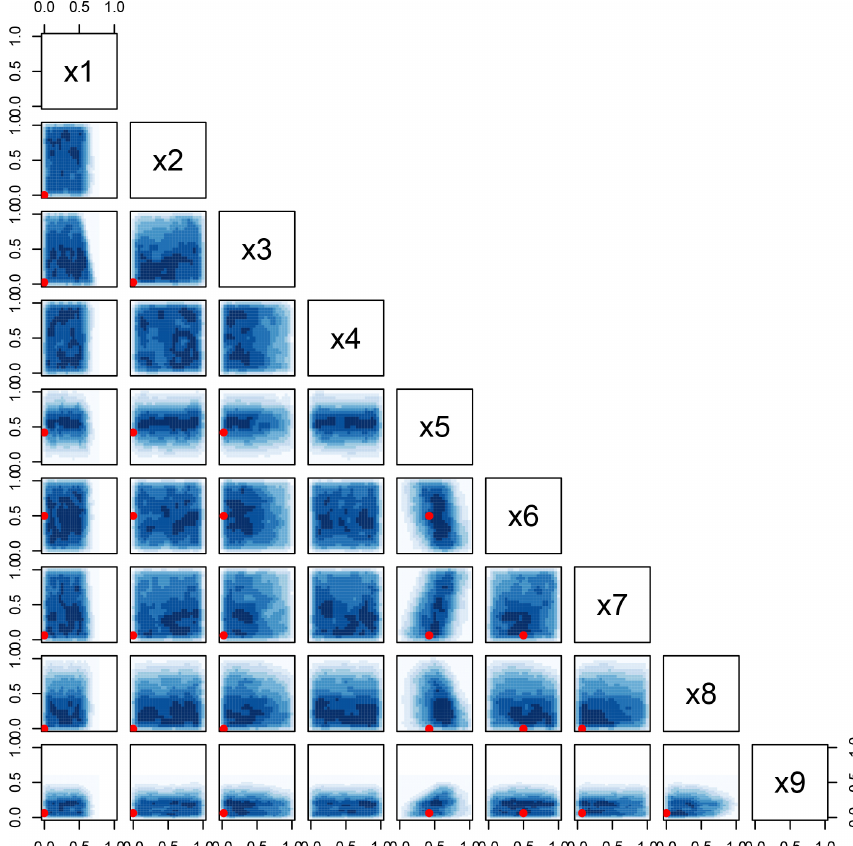
Figure 5. The blue shading in each panel indicates the density of plausible cases for each pair of input parameters ( x 1 – x 9 ), displayed in standardized units. Plausible cases are defined as the subset of n = 100000 emulated samples with SS > 0.85, and dAOD < 0.08. Darker shading indicates higher density, and white areas indicate very low density. The default values for each parameter in CAM4 are indicated by red dots in each panel (except for x 4 , which has no